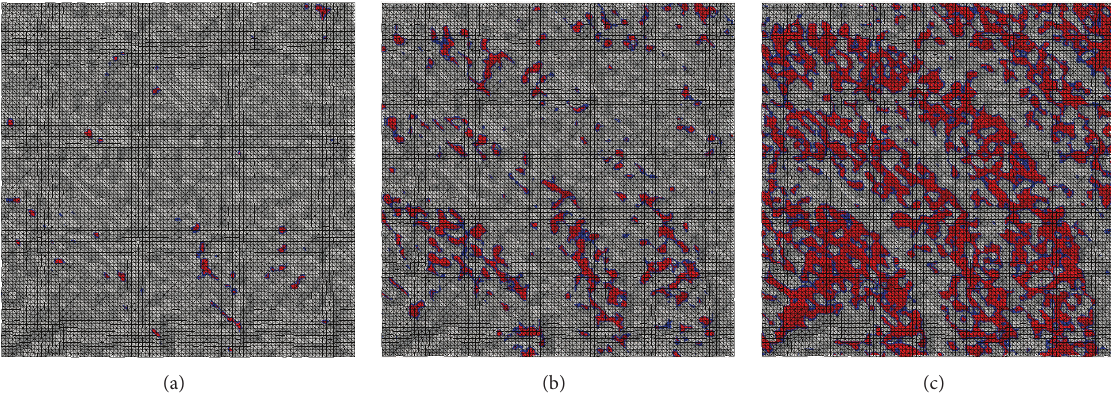
Figure 12: Effective contact surface at 79% of the applied load (a); at 89% of the applied load (b); at 100% of the applied load (c).